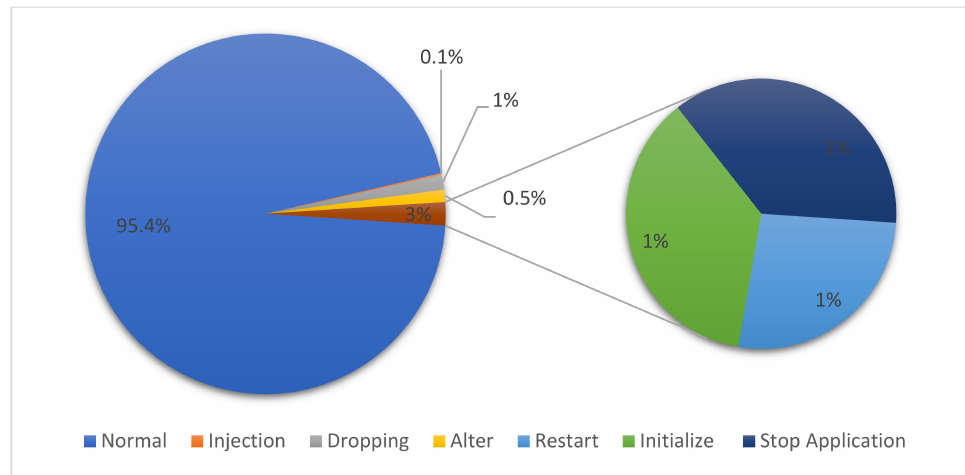
Figure 8. Function codes distributions for dataset